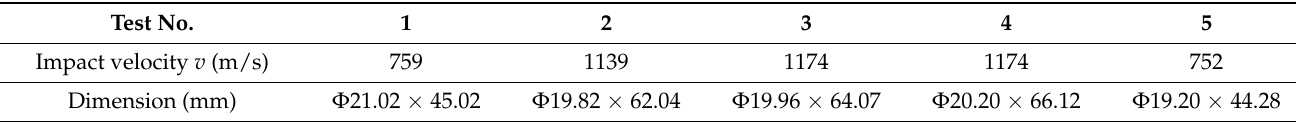
Table 10. Perforation dimension of armor with two layers of PE. Test No.